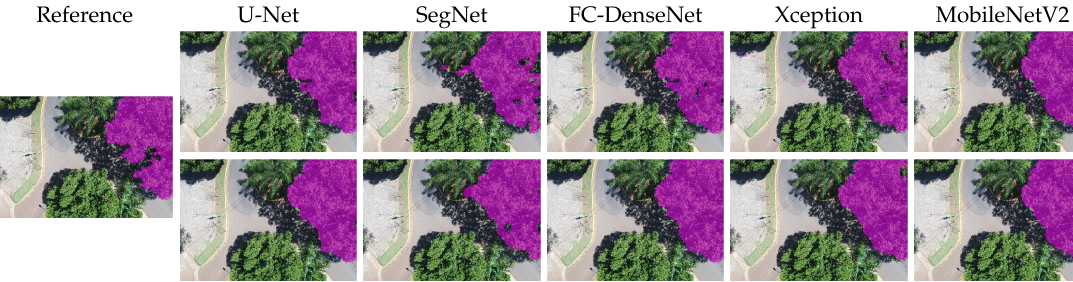
Figure 12. Sample Segmentation 3 prior (first row) and after CRF post-processing (second row).